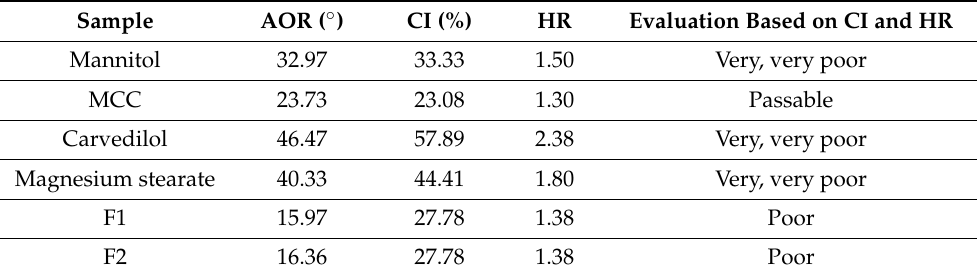
Table 4. Angle of repose, Carr’s index (CI), Hausner ratio (HR), and evaluation based on CI and